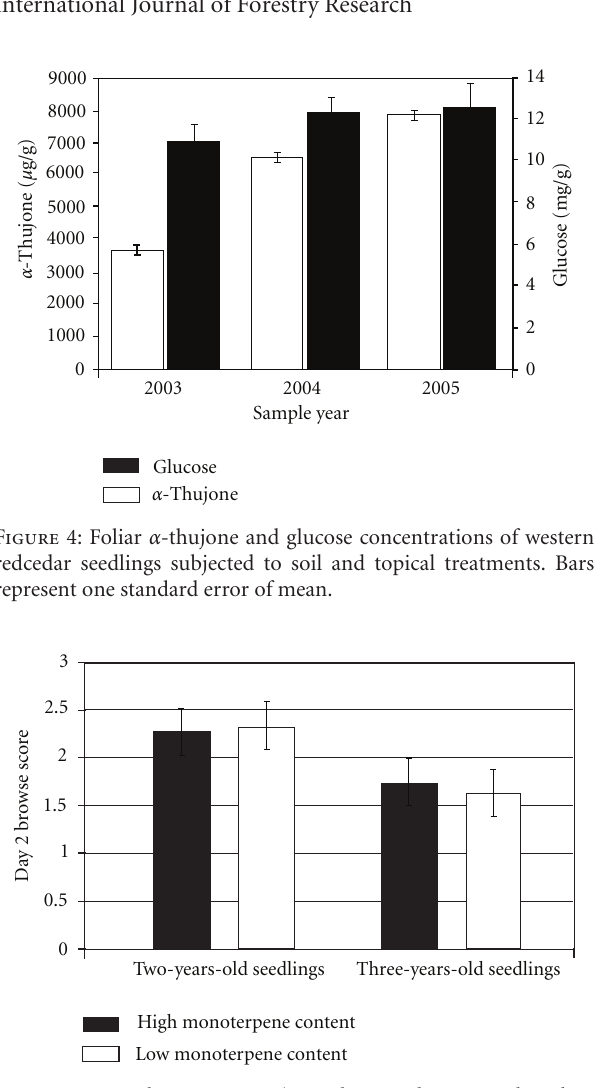
Figure 5: Mean browse scores (0: no browse damage; 1: less than 10 bites; 2: more than 10 bites; or 3: totally denuded) of redcedar seedlings o ff ered to captive deer in a factorial